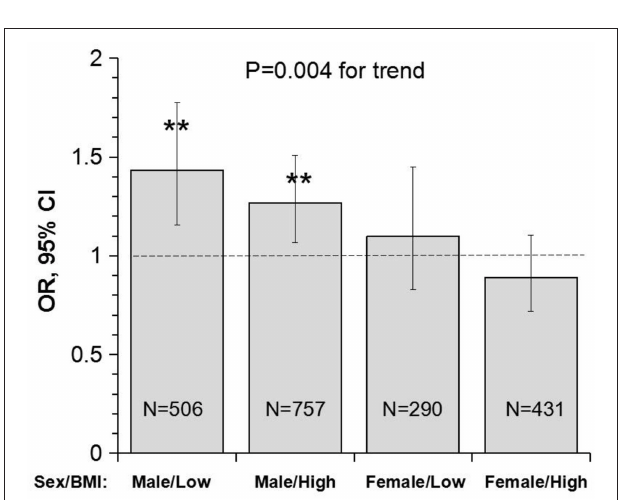
FIGURE 3 | Odds ratio and 95% confidence interval of lower uric acid for poor outcome (mRS ≥ 3) with quartile 4 of uric acid (the highest) as reference by sex/BMI groups. Low and high BMI was defined by the threshold of 24; ** P < 0.01 for OR > 1. BMI, body mass index; CI, confidence interval; mRS, modified Rankin scale; OR, Odds